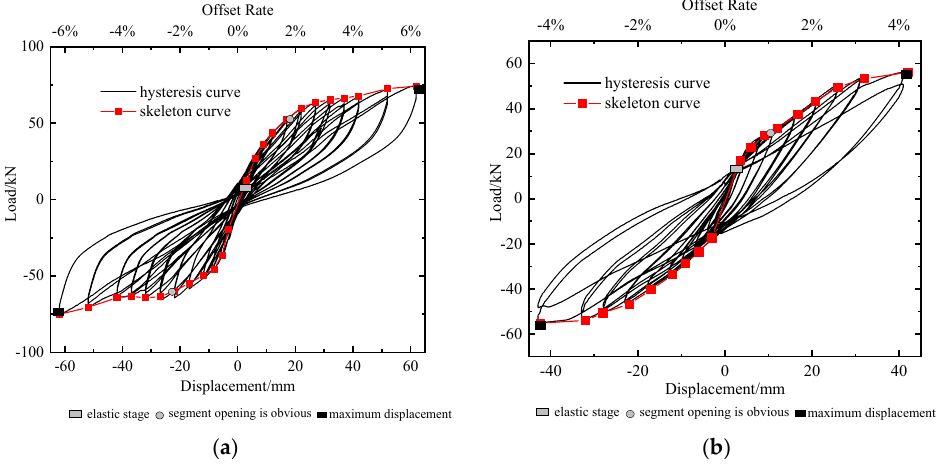
Figure 15. Loading mechanical behavior of segmental assembled CFST piers, ( a ) CFST − R test specimen, ( b ) CFST − 0 test specimen. specimen, ( b ) CFST − 0 test